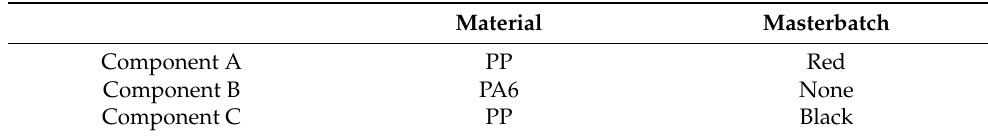
Table 2. The materials used in the experiments.